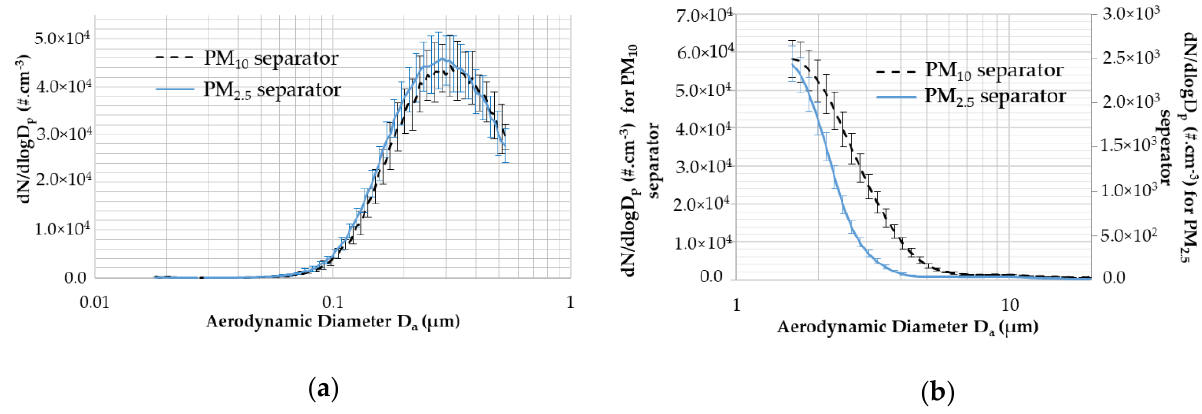
Figure 2. Size distribution of aerosol obtained with the scanning mobility particle sizer spectrometer (SMPS) and aerodynamic particle sizer spectrometer (APS) devices. ( a ) Size distribution of the aerosol obtained with SMPS expressed in terms of the mobility diameter D m ( µ m). ( b ) Size distribution of the aerosol obtained with APS expressed in terms of the aerodynamic diameter D a (µm).